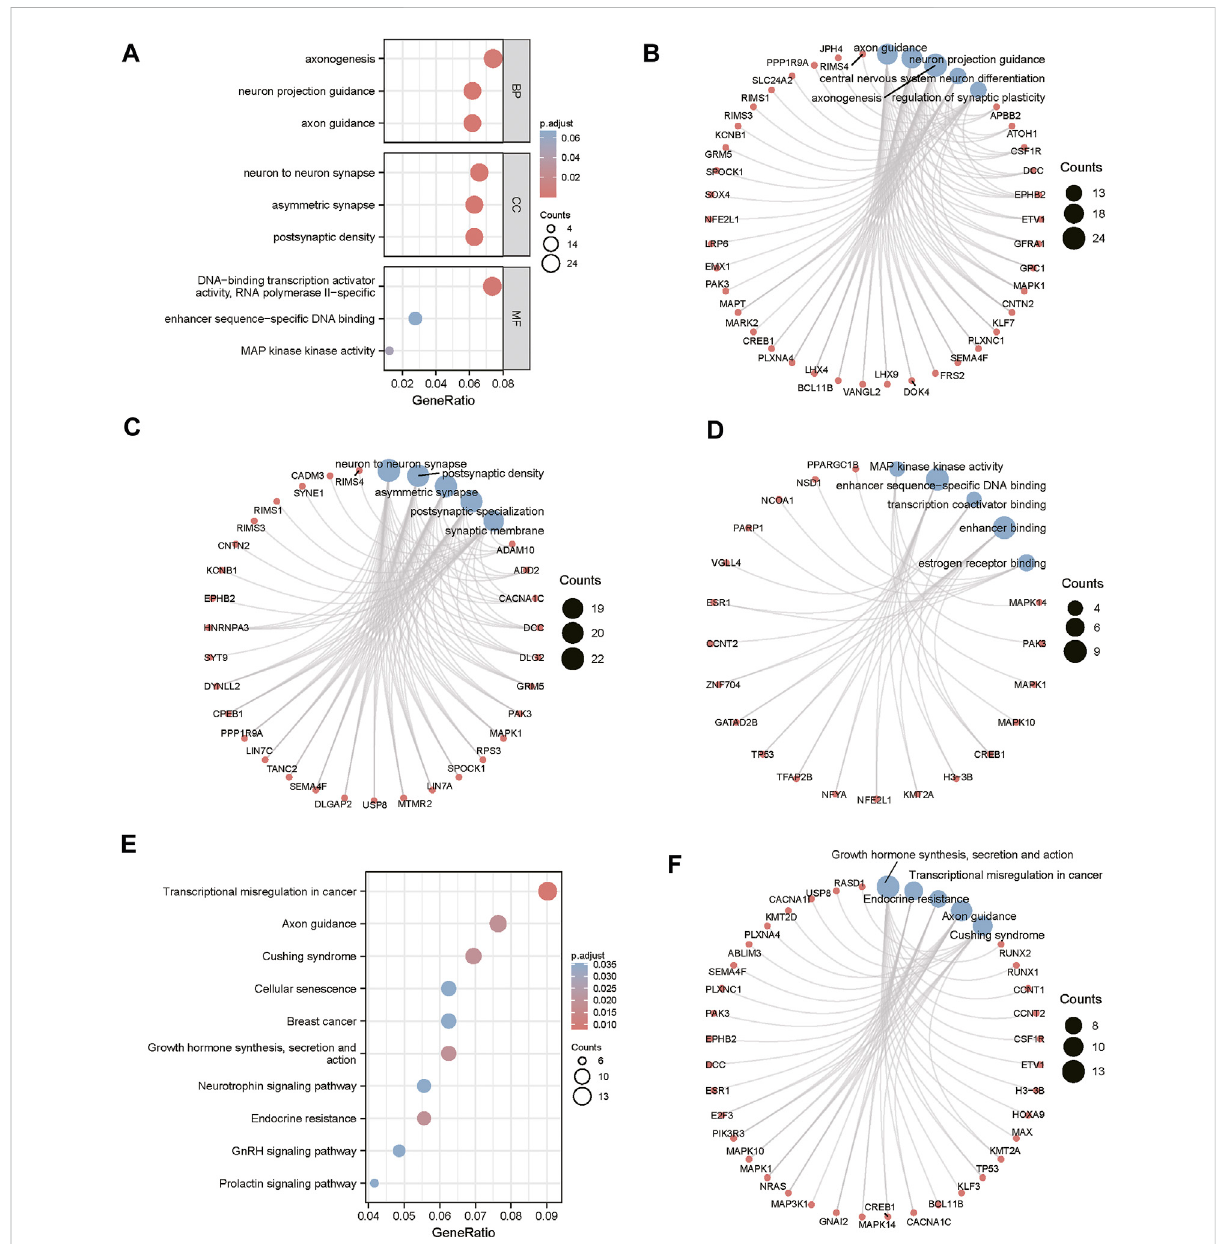
FIGURE 3 Functional correlation analysis of DEGs. (A) Functional enrichment analysis of the overall biology of GO. The X horizontal axis indicates the proportionofDEGsenrichedintheGOterms,andthecolorofthedotsshowsthesigni fi cant p -value:theredderthecolor,thesmallerthecorrected p -value; the bluer the color, the larger the corrected p -value. The size of the dots represents the number of enriched genes. (B) BP functional enrichment analysis; the color of the dots indicates the |logFC| of the genes. (C) CC functional enrichment analysis. (D) MF